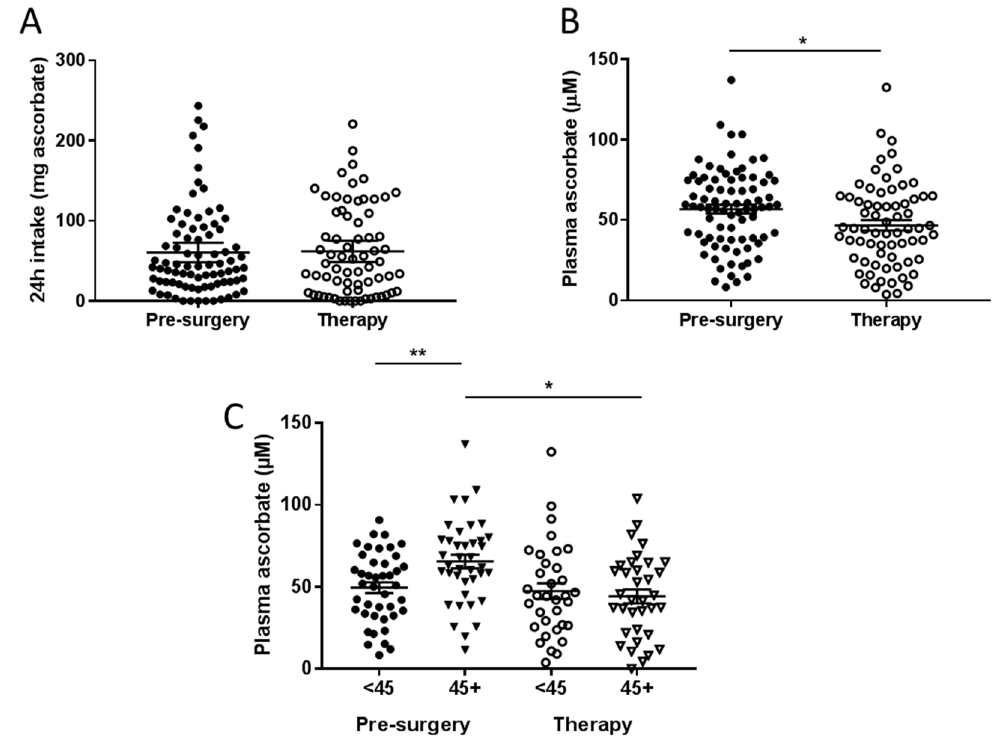
Figure 1. Ascorbate intake ( A ) and plasma ascorbate concentrations ( B ) in fasting patients from the pre-surgical and therapy cohorts. ( C ) Plasma ascorbate levels according to reported intake dicotemized at NZ recommended daily intake (RDI) of 45 mg/day. Pre-surgical cohort n = 81; therapy